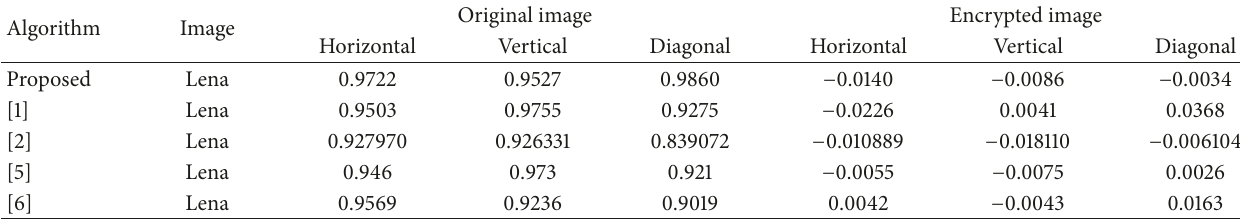
Figure 28: Cameraman. Table 2: Comparison of correlation coefficients of